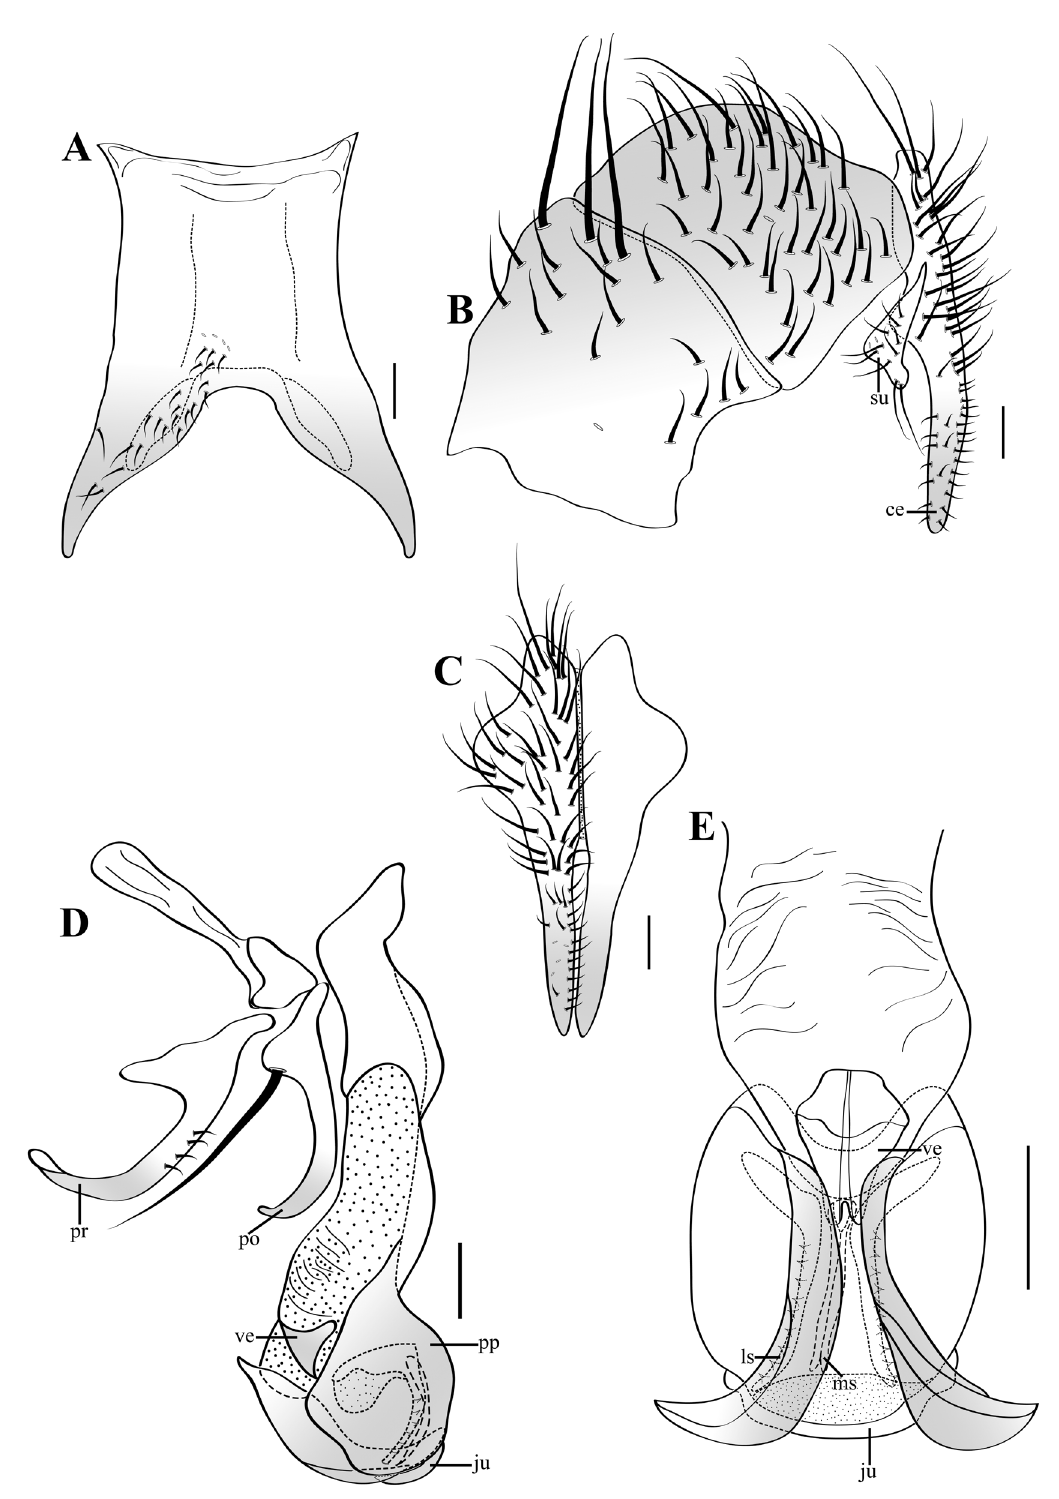
Fig. 9. Dexosarcophaga sphaera sp. nov., ♂, paratype (MNRJ [lost]), Brazil, Minas Gerais, Uberlândia. A . Sternite 5, ventral view. B . Syntergosternite 7 + 8, epandrium, cercus and surstylus, lateral view. C . Cerci, posterior view. D . Phallus and associated structures, lateral view. E . Distiphallus, ventral view. Abbreviations: see Material and methods. Scale bars = 0.1